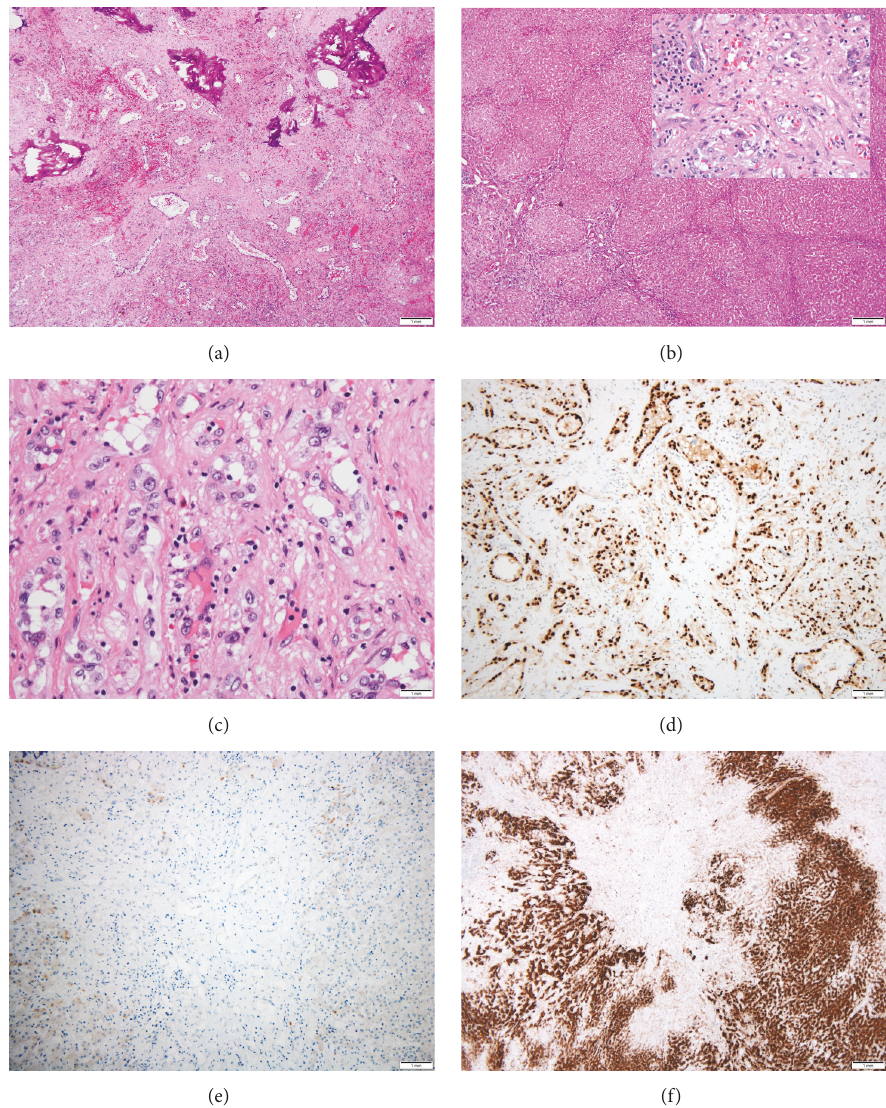
Figure 2: Photomicrographs of hepatic epithelioid hemangioendothelioma. (a) This mass shows one of the low magnification morphologic patterns of this tumor; well-formed vascular channels in a sclerotic matrix with focal calcification (original magnification x 100). (b) Other areas resembled focal nodular hyperplasia with a multinodular proliferation of hepatocytes around a stellate area of fibrosis (original magnification x40). (inset) The tumor cells characterized by mild nuclear atypia and abundant cytoplasm subtly infiltrate the collagen as seen in the center of this image (original magnification x400). (c) This photomicrograph shows the second phenotype of the tumor cells. Instead of well-formed vascular channels, the tumor cells are characterized by pale eosinophilic cytoplasm and intracytoplasmic vacuoles (original magnification x400). (d) The endothelial phenotype of the tumor cells is confirmed by strong and diffuse expression ERG (original magnification x100). (e) Tumor cells are negative for CAMTA1 (original magnification x100). (f) The mimic of typical focal nodular hyperplasia extended beyond hematoxylin and eosin stained stains to a map-like expression of glutamine synthetase (original magnification